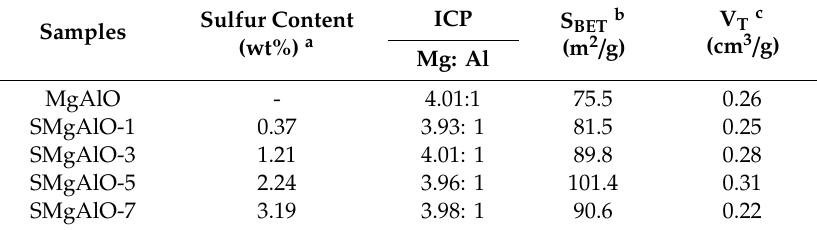
Table 1. Textural properties of the mixed metal oxide derived from hydrotalcite series with di ff erent sulfur